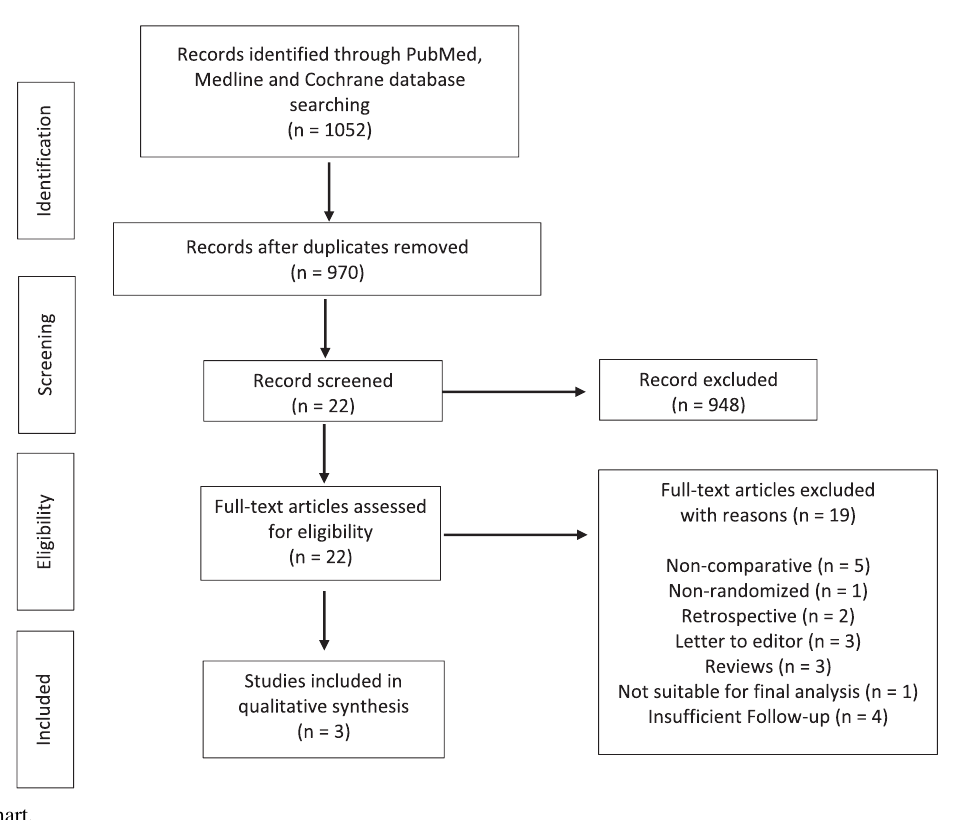
Figure 1. Flow chart.